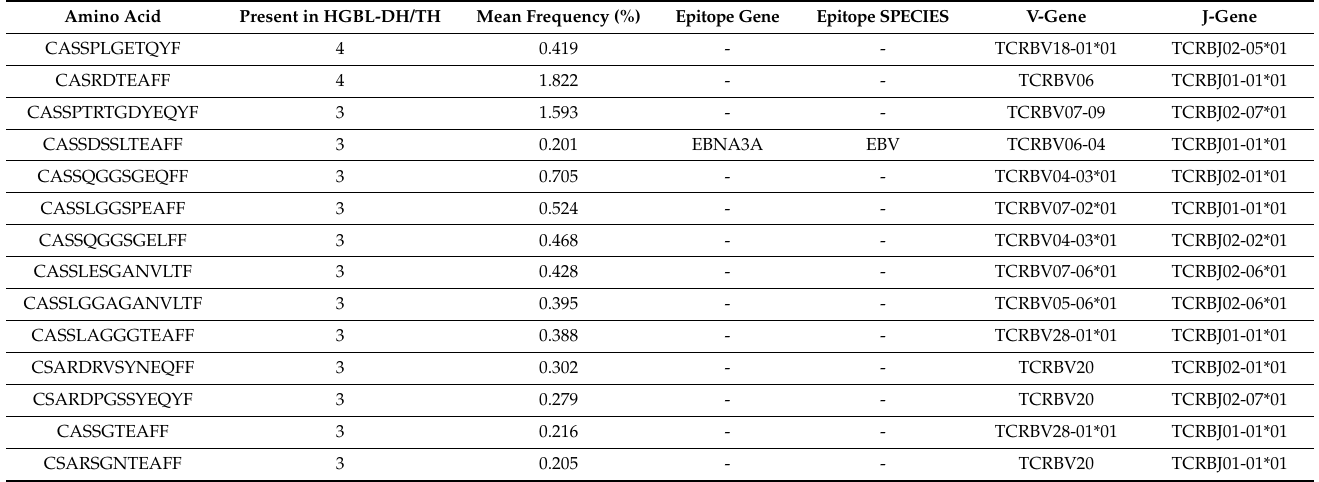
Table 5. Major public T-Cell Receptor β CDR3 clonotypes found in HGBL-DH/TH but not tnDLBCL suggestive of a process of shared tumor-neoantigen selection within the tumor-infiltrating TCR repertoire, cross referenced with a publically available